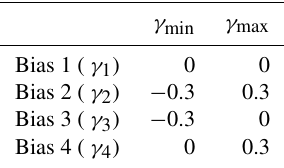
Table 3. Minimum and maximum values γ min and γ max in 4 differ- ent cases of observation bias used in experiment 1.2 and